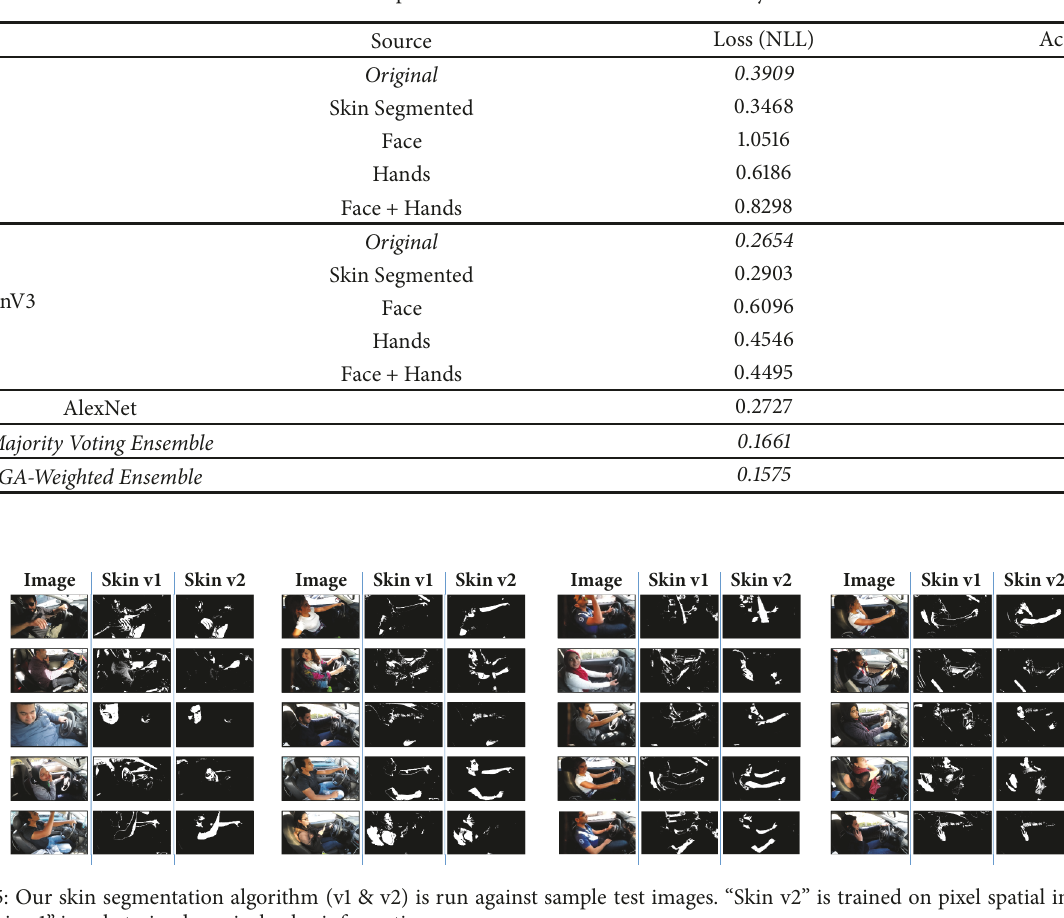
Table 1: Distracted driver posture classification results on randomly selected test data.